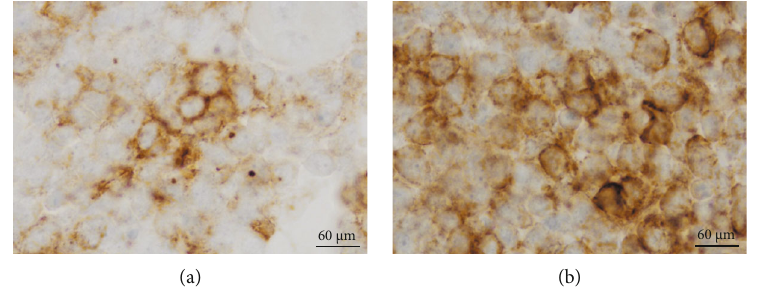
Figure 1: (a) Pericardial fl uid CD10+. (b) Pericardial fl uid CD19+.